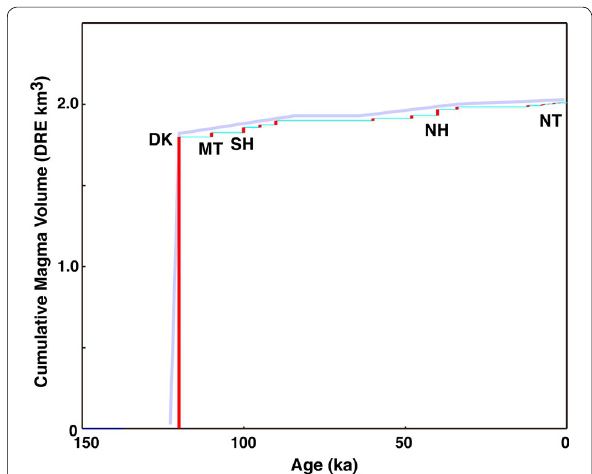
Fig. 18 Cumulative magma volume erupted from Adatara Volcano. A red solid line represents an eruption event. A lilac solid line shows a tendency of the eruption rate. DK Dake tephra; MT Matsukawa = = tephra; SH Sahara tephra; NH Nihonmatsu tephra; NT Numano- = = = taira tephra group (Yamamoto and Sakaguchi 2000)